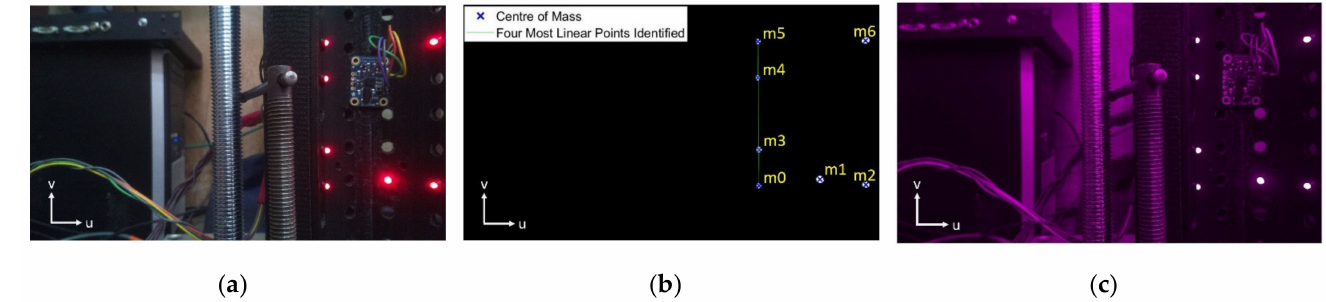
Figure 4. Image filtering and 2D–3D Correspondence; ( a ) Unprocessed image; ( b ) Segmented image with applied morphological operations and correspondence (see Section 5.3); ( c ) Difference between the processed and unprocessed